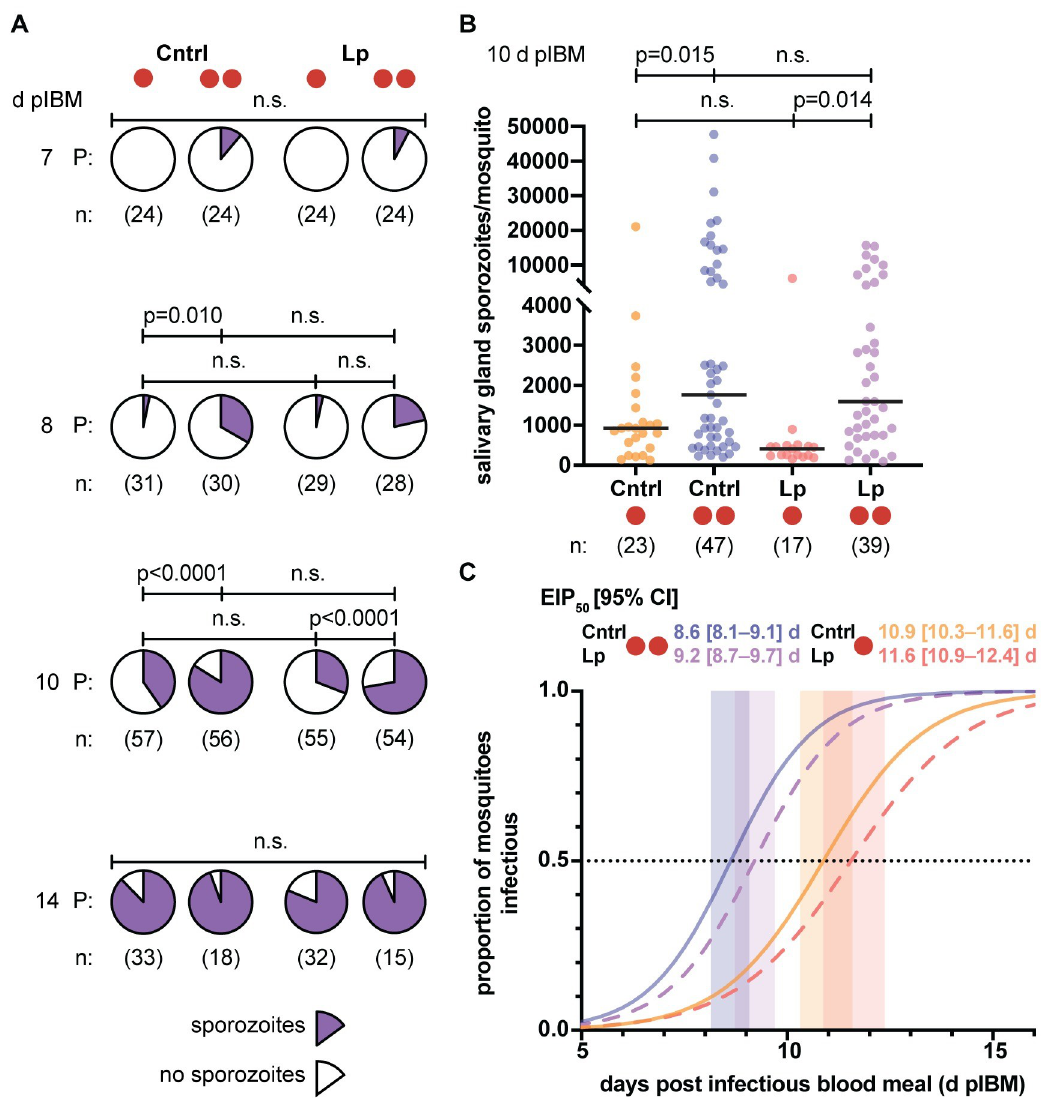
Fig 3. Mosquitoes are infectious sooner following a second blood meal. (A–B) Salivary glands of females fed twice (two red circles) show (A) a significantly higher prevalence (P, pie charts) of sporozoites at 8 and 10 d pIBM ( χ 2 test: 8 d, χ 2 = 15, d.f. = 3, p = 0.0018; 10 d, χ 2 = 43, d.f. = 3, p < 0.0001; FDR-corrected post-hoc χ 2 tests shown) and (B) significantly more sporozoites at 10 d pIBM (Linear mixed model; #BF: p = 0.0001; FDR-corrected post-hoc Student’s t tests shown) than females fed once (one red circle). Horizontal bars indicate median values. There is no difference in sporozoite prevalence at a later time point ( χ 2 test: 14 d, χ 2 = 2.4, d.f. = 3, n.s.). (C) The EIP 50 (time to 50% infectious–dotted line; values also shown ± 95% C.I.) of control (Cntrl) females fed a second time (blue solid line) is reduced by 2.3 d (21%) compared with controls fed once (orange solid line), as determined from the sporozoite prevalence data shown in (A) (z test, Z = 5.7, p < 0.0001). Similarly, EIP 50 is reduced by 2.4 d (20%) in Lp-depleted females fed a second time (purple dashed line) compared to those fed once (red dashed line) (z test, Z = 5.3, p < 0.0001). Fitted logistic curves (lines), EIP 50 ± 95% C.I. (shaded). n = numbers of mosquitoes analyzed from 4 different experiments. n.s. = not statistically significant. See S1–S4 Tables for details of statistical